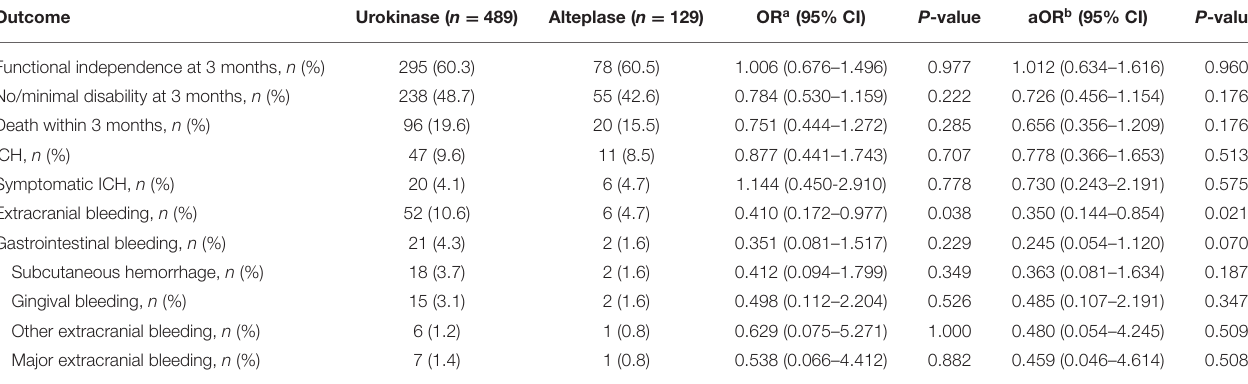
TABLE 2 | Outcomes and treatment complications in patients treated with urokinase or alteplase. Outcome